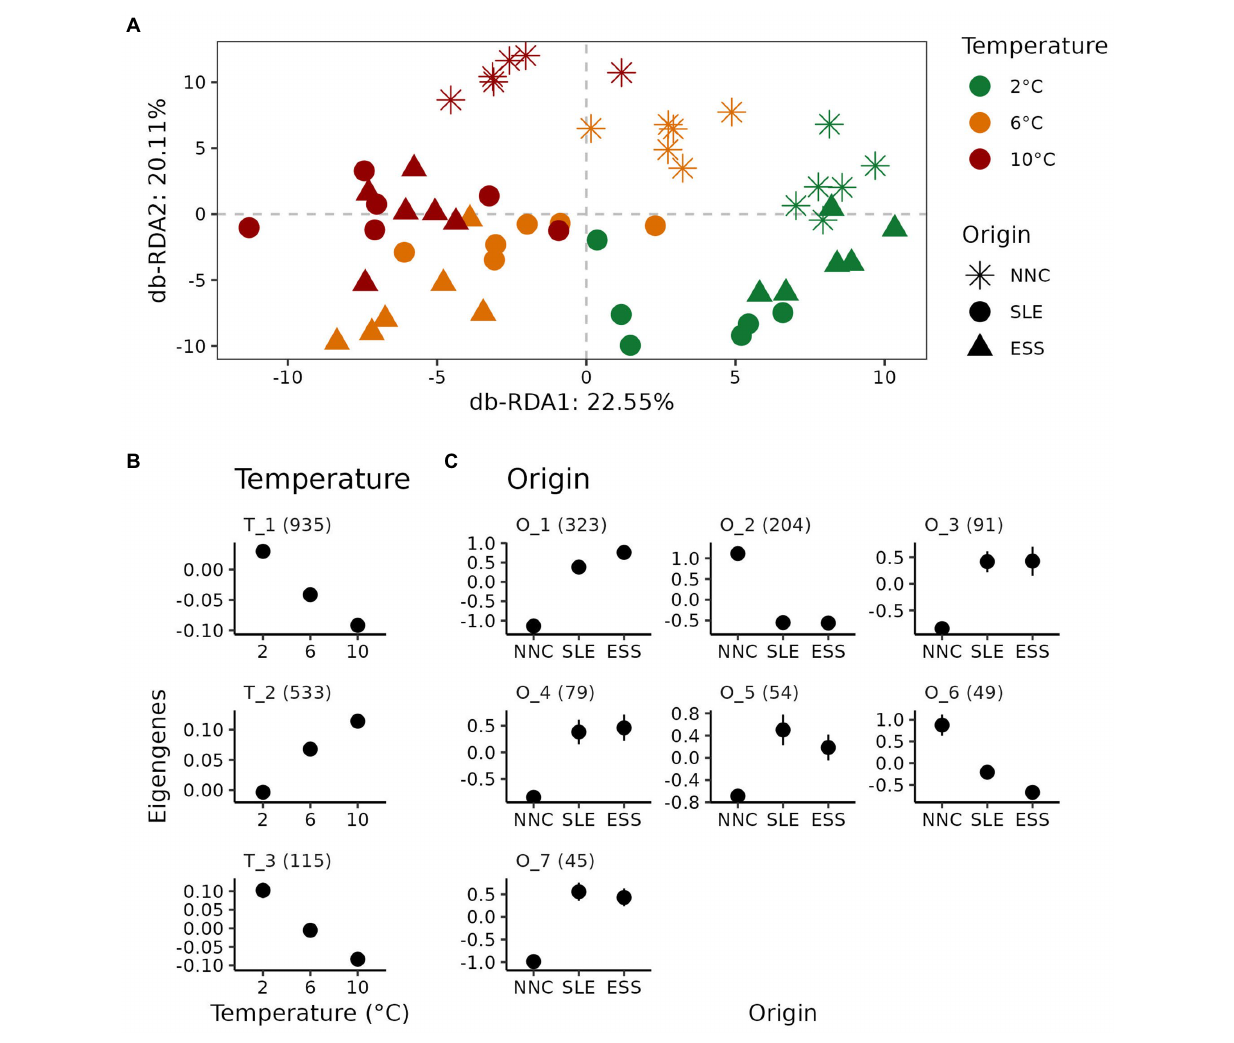
FIGURE 3 Gene expression response to temperature exposure of P. borealis shrimp from three different origins. (A) Variation of gene expression levels. Distance- based redundancy analysis (db-RDA) plot performed on gene expression levels according to origins (shapes) and temperature treatments (colors). (B,C) Relative expression level for each co-expression modules for differentially expressed transcripts (DETs) among temperatures (T) and origins (O), respectively. Means with their standard errors are represented as dots and error bars, respectively. Numbers in parentheses indicate the number of transcripts belonging to each co-expression